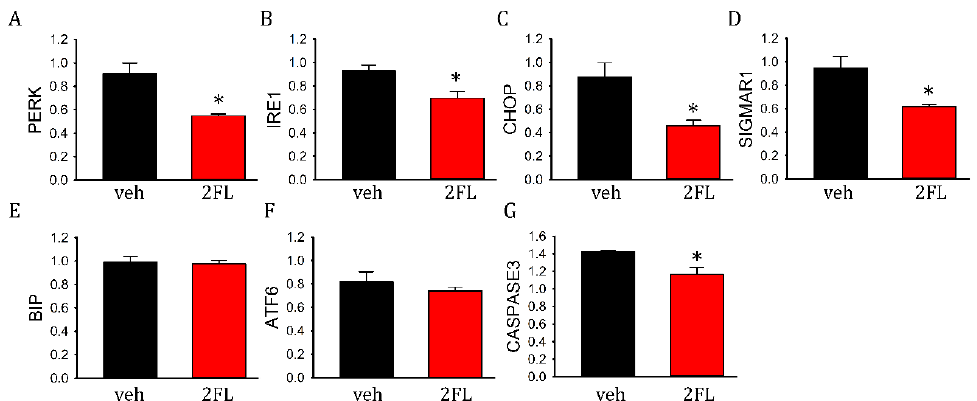
Figure 6. 2FL suppressed the expression of ER stress and apoptotic markers. The expression of ( A ) PERK, ( B ) IRE1, ( C ) CHOP, ( D ) SigmaR1, and ( G ) caspase3 was significantly inhibited by 2FL in hemorrhagic brains. The expression of ( E ) BIP and ( F ) ATF6 was not altered by 2FL. * p < 0.05. ER, endoplasmic reticulum; PERK, protein kinase R-like ER kinase; IRE1, inositol-requiring enzyme 1; CHOP, CCAAT enhancer-binding protein homologous protein; SigmaR1, Sigma 1 receptor; ATF6, activating transcription factor